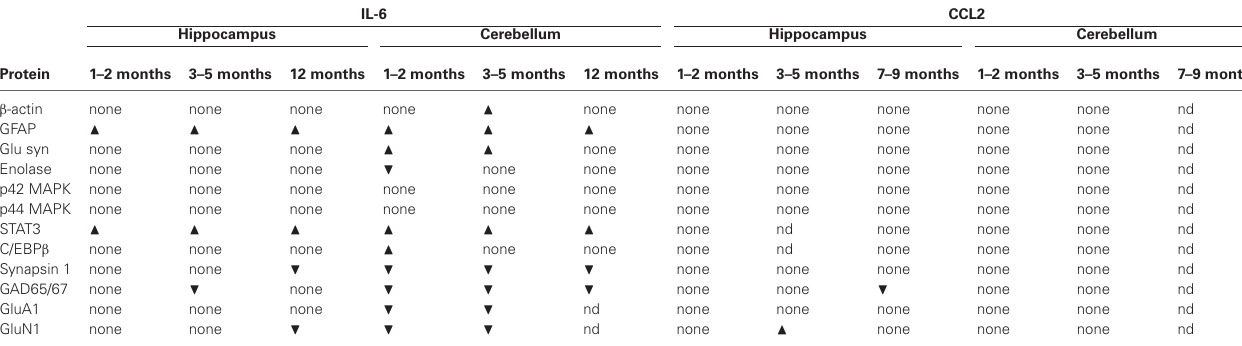
Table 1 | Changes in protein expression in hippocampus and cerebellum of IL-6 and CCL2 transgenic mice. IL-6 CCL2 Hippocampus Cerebellum Hippocampus Cerebellum